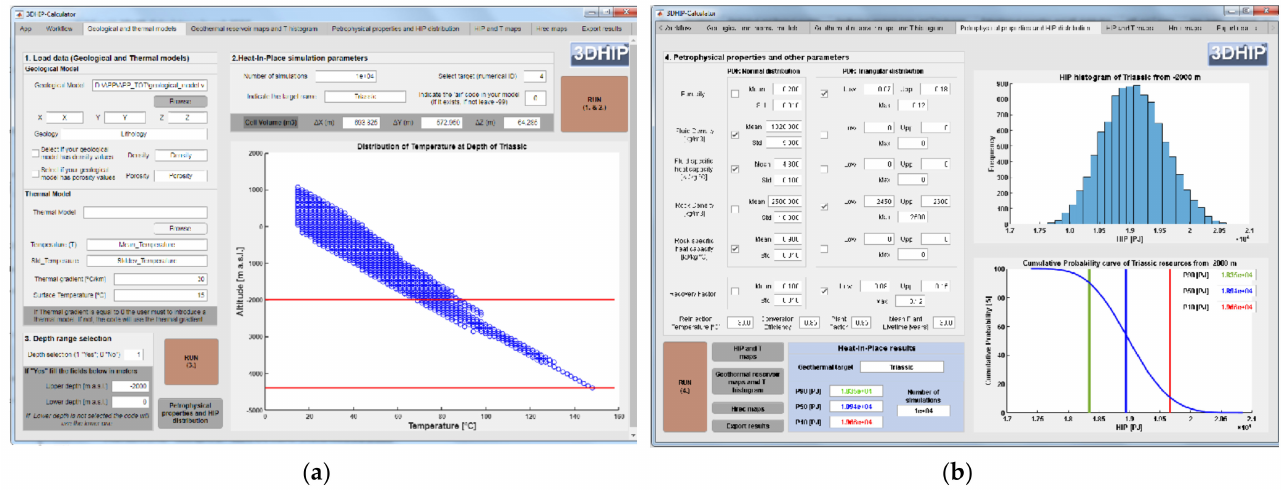
Figure 5. ( a ) Depth–temperature distribution for the Triassic unit using a linear geothermal gradient (example 2). Each blue circle corresponds to a temperature value of each of the voxels that discretize the Triassic unit. The red lines indicate the fixed depth range for the HIP and Hrec calculations. ( b ) Petrophysical and operational properties, and the corresponding PDFs used for this example. On the right-side: the HIP histogram and its CDF (blue curve) with the P10 (red line), P50 (blue line), and P90 (green line) for the entire targeted